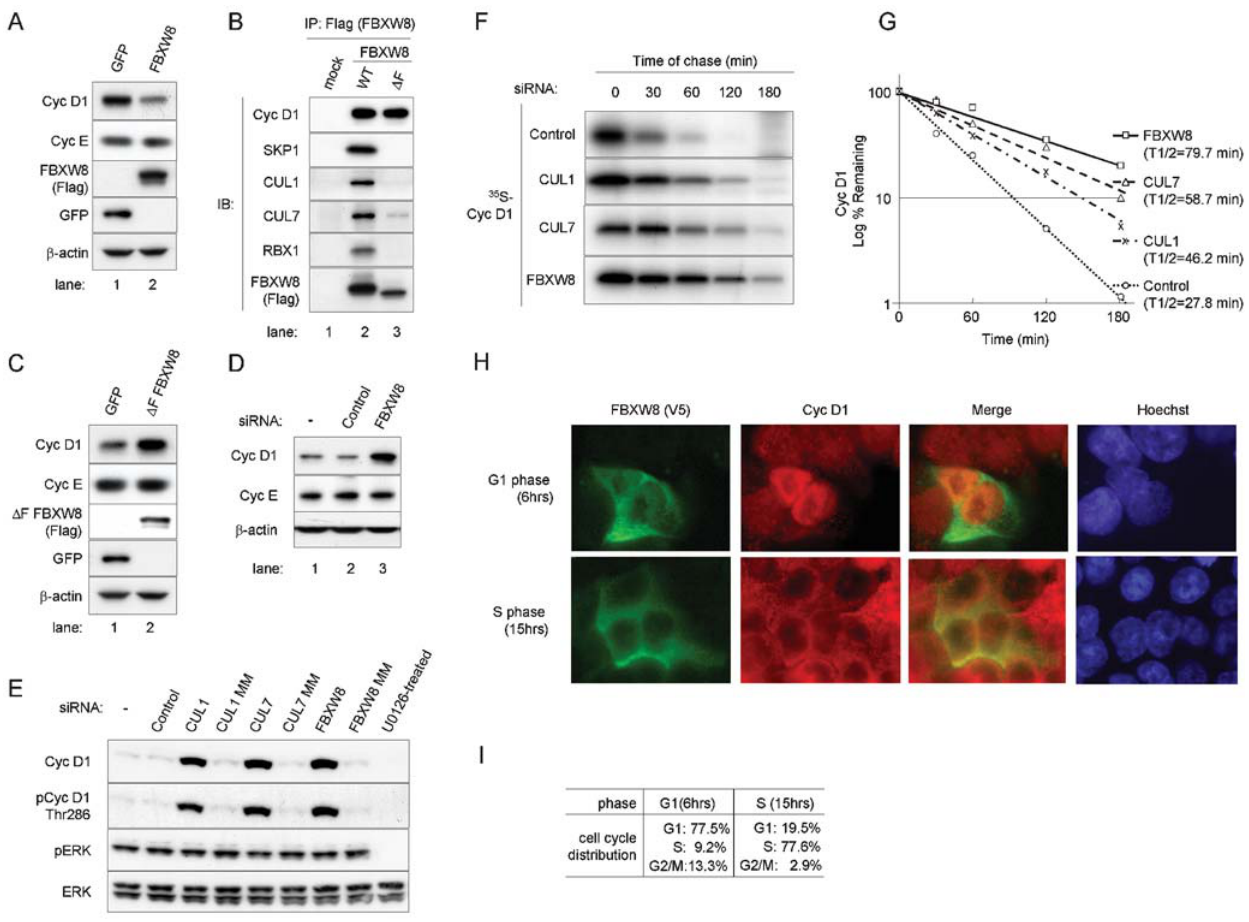
Figure 4. The stability of cyclin D1 is regulated by FBXW8 complexes through the ubiquitin-proteasome pathway. (A, C) IB analysis. HCT 116 cells were infected with a retrovirus expressing FBXW8 (A), a D F mutant form ( D F FBXW8, Panel C) or a control retrovirus expressing GFP (A, C). Forty-eight hours later, cells were harvested and Western blot analysis was performed with antibodies to cyclin D1, cyclin E, Flag (FBXW8 and D F FBXW8), GFP and b -actin. (B) IP–IB analysis. Empty (mock) or Flag-tagged WT FBXW8, and D F FBXW8 DNA plasmids were transiently transfected in T98G cells. Samples were precipitated with a Flag epitope tag antibody. Immunoprecipitates were subjected to SDS-PAGE and subsequently blotted with antibodies to cyclin D1, SKP1, CUL1, CUL7, RBX1 and Flag (F-box proteins). (D) IB analysis following depletion of FBXW8 expression for 48 hrs through siRNA in HCT 116 cells. Non-targeting siRNA (Control) and mock transfection ( 2 ) were controls. (E–G) Knockdown of FBXW8 or its partner CUL1 or CUL7 through siRNA stabilizes cyclin D1 expression in HCT 116 cells. (E) IB analysis following depletion of CUL1, CUL7 or FBXW8 expression for 48 hrs through siRNA or mismatch (MM) oligonucleotides in HCT 116 cells. Non-targeting siRNA (Control) and mock transfection ( 2 ) were controls. (F, G) Pulse-chase analysis of cyclin D1 following depletion of CUL1, CUL7 or FBXW8 expression for 48 hrs through siRNA in HCT 116 cells. Control cells were treated with non-targeting siRNA. Cells were pulse-labeled with 35 S-methionine for an hour, chased with cold methionine as indicated, and then lysed. Cyclin D1 was immunoprecipitated and analyzed via SDS-PAGE. (G) Levels of metabolically labeled-cyclin D1 were estimated by quantitative scanning using Quantity One software and plotted graphically to determine the half-life of cyclin D1. (H, I) Immunofluorescence. Nuclei were visualized with Hoechst dye. Subcellular localization of E3 ligase. HCT 116 cells were transfected with V5 epitope-tagged FBXW8 pcDNA3. Cells were synchronized 24 hrs later by sequential manipulation of serum starvation and stimulation. At 6 hrs (G1 phase) or 15 hrs (S phase), cells were fixed. Immunofluorescence was performed with a V5 epitope tag antibody followed by Alexa Fluor 488- conjugated anti-mouse IgG antibody (green) and a rabbit cyclin D1 polyclonal antibody followed by Alexa Fluor 594-conjugated anti-rabbit IgG antibody (red). (I) Cell cycle distributions.